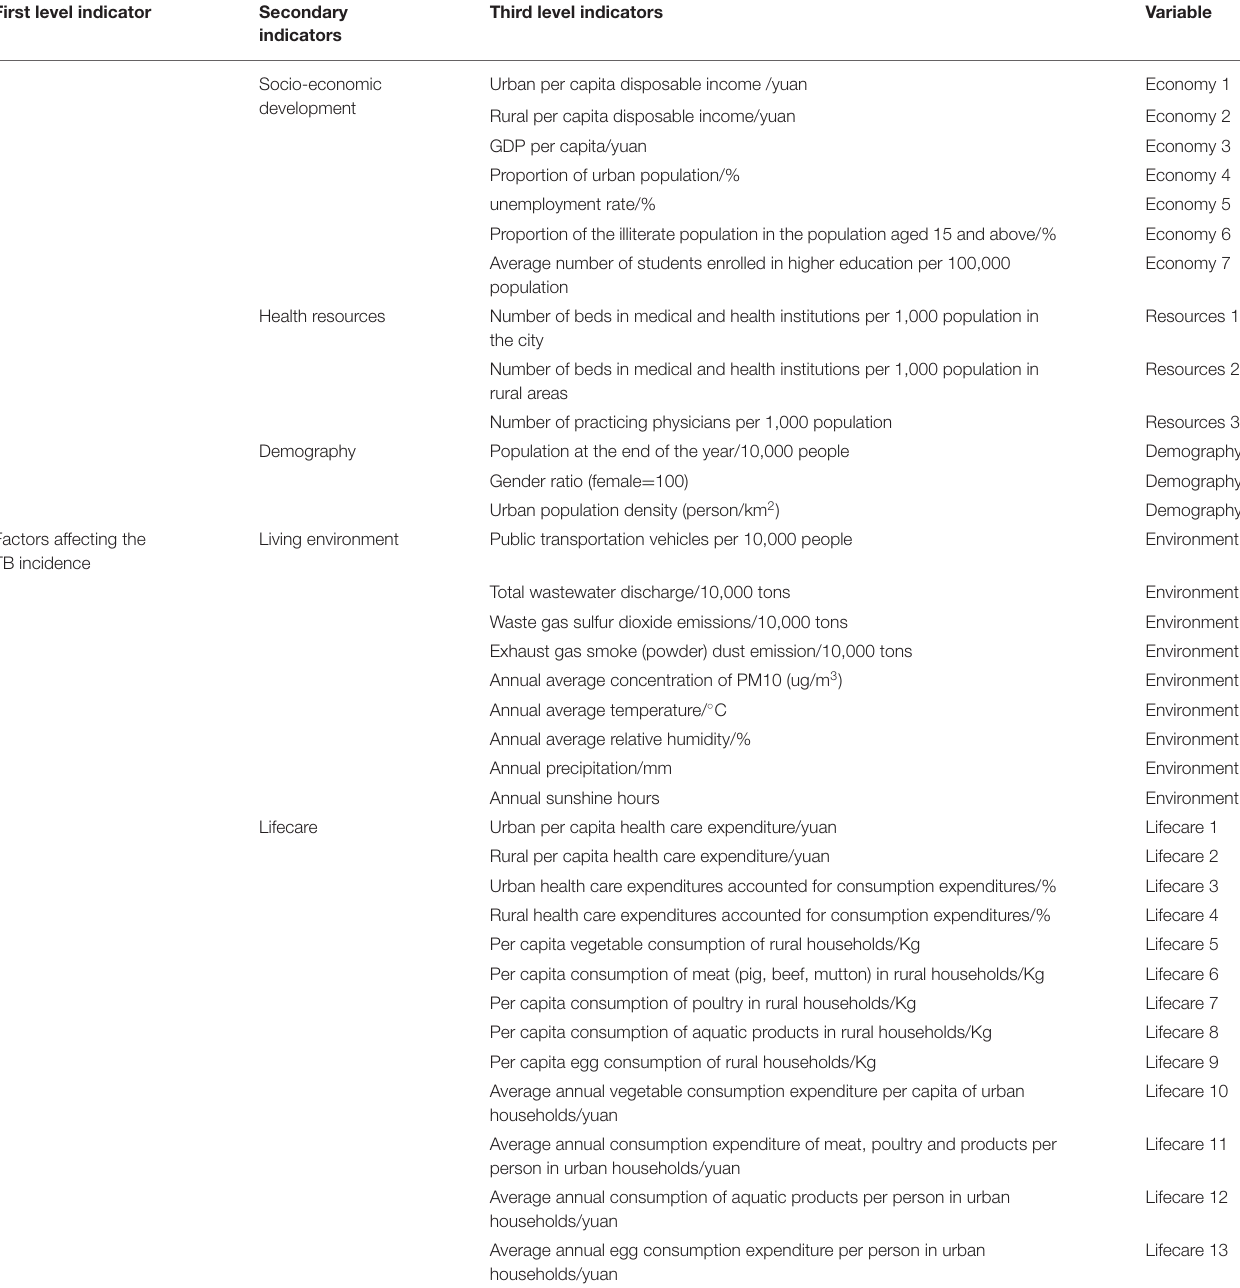
TABLE 1 | The framework of ecological factors influencing the incidence of pulmonary